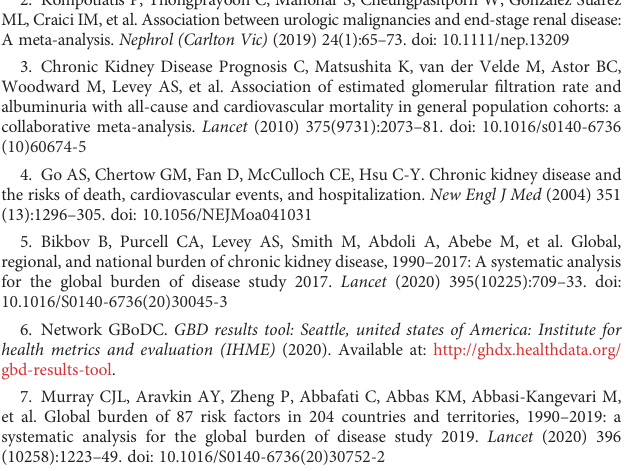
SUPPLEMENTARY TABLE 1 Number and age-standardized rates of deaths, disability-adjusted-life-years (DALYs), years of life lost (YLLs), and years lived with disability (YLDs) attributable to kidney dysfunction in 1990 and 2019 and the overall percentage changes from 1990-2019 in Iran by province. SUPPLEMENTARY FIGURE 1 Trend of age-standardized rate of years of life lost (YLLs), years lived with disability (YLDs), deaths, and disability-adjusted life years (DALYs) attributable to kidney dysfunction in Iran from 1990 to 2019 by sex. SUPPLEMENTARY FIGURE 2 Age-standardizedrateofyearsoflifelost(YLLs),yearslivedwithdisability(YLDs), deaths, and disability-adjusted life years (DALYs) attributable to kidney dysfunction among both sexes in Iran in 1990 by province. SUPPLEMENTARY FIGURE 3 Age-standardizedrateofyearsoflifelost(YLLs),yearslivedwithdisability(YLDs), deaths, and disability-adjusted life years (DALYs) attributable to kidney dysfunction among both sexes in Iran in 2019 by province. SUPPLEMENTARY FIGURE 4 Trend of age-standardized rate of years of life lost (YLLs), years lived with disability (YLDs), deaths, and disability-adjusted life years (DALYs) attributable to kidney dysfunction in Iran from 1990 to 2019 by province. SUPPLEMENTARY FIGURE 5 Age-standardizedrateofyearsoflifelost(YLLs),yearslivedwithdisability(YLDs), deaths and disability-adjusted life years (DALYs) attributable to kidney dysfunction in provinces of Iran in 1990 and 2019 by sex and age. SUPPLEMENTARY FIGURE 6 Age-standardized rate of disability-adjusted life years (DALYs) attributable to kidney dysfunction in Iran in 1990 and 2019 by socio-demographic index (SDI) quintiles and province. SUPPLEMENTARY FIGURE 7 Age-standardized rate of deaths attributable to kidney dysfunction in Iran in 1990 and 2019 by socio-demographic index (SDI) quintiles and